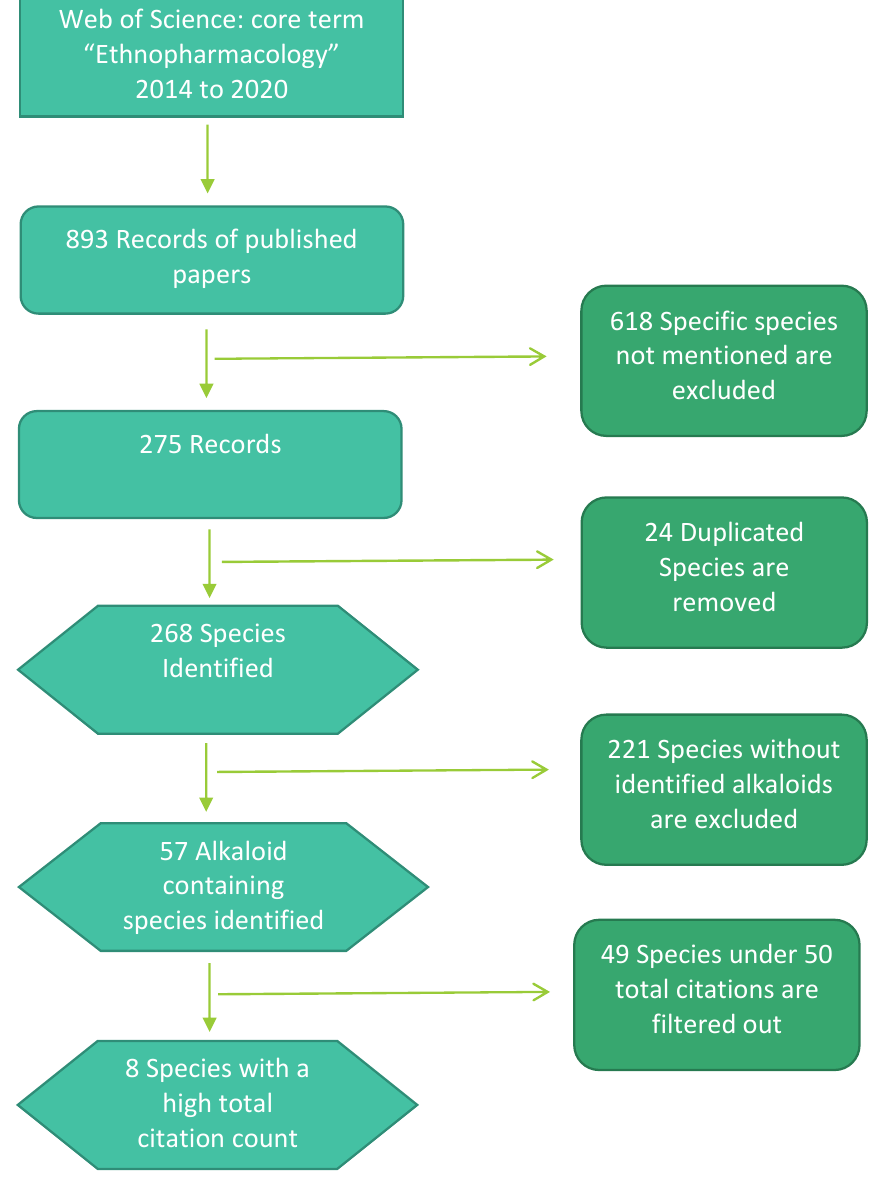
Figure 1. Flow chart indicating the selection strategy for identifying widely distributed alkaloid containing species currently researched as food